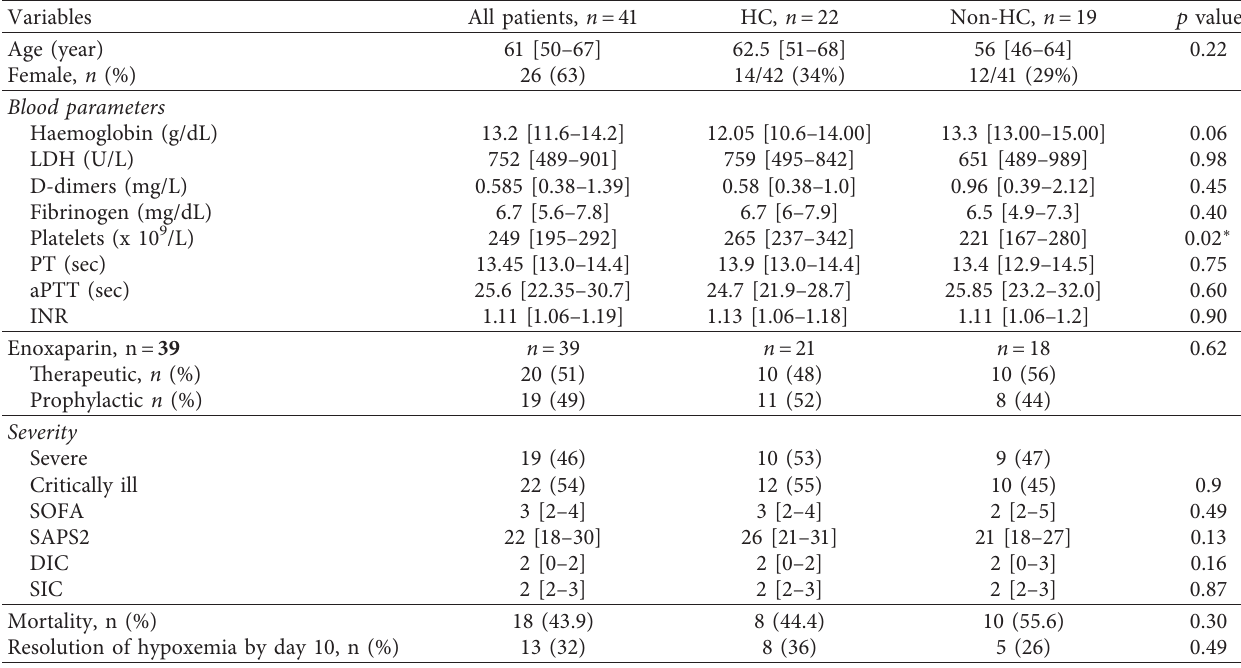
Table 2: Non-TEG characteristics.